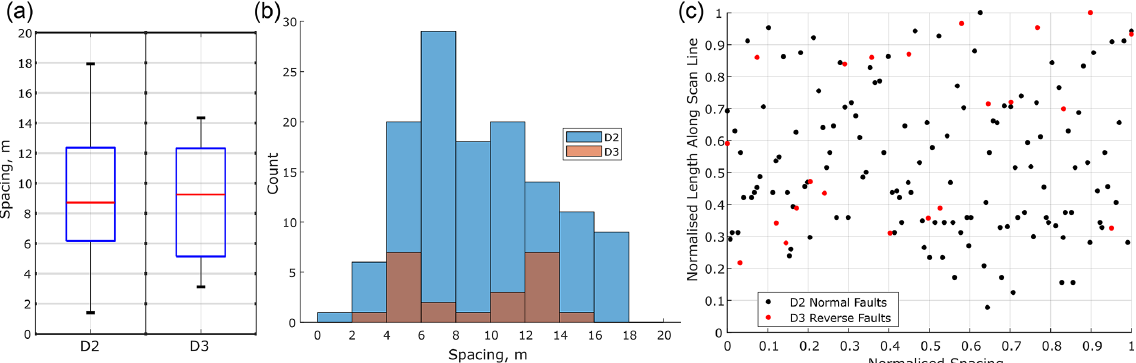
Figure 15. (a) Box-and-whisker plots of the corrected spacing distribution of D2 normal faults and D3 reverse faults. (b) Histograms of the corrected spacing distribution of D2 normal and D3 reverse faults. A normality test (Lilliefors test; MathWorks, 2011) shows that D2 has a normal distribution, while normality is rejected for D3. D2 shows a positive skew, and D3 has a bimodal distribution. (c) The plot of the normalised spacing against distance from the start of the scan line for normal and reverse faults. The plot most closely resembles Fig. 15b and